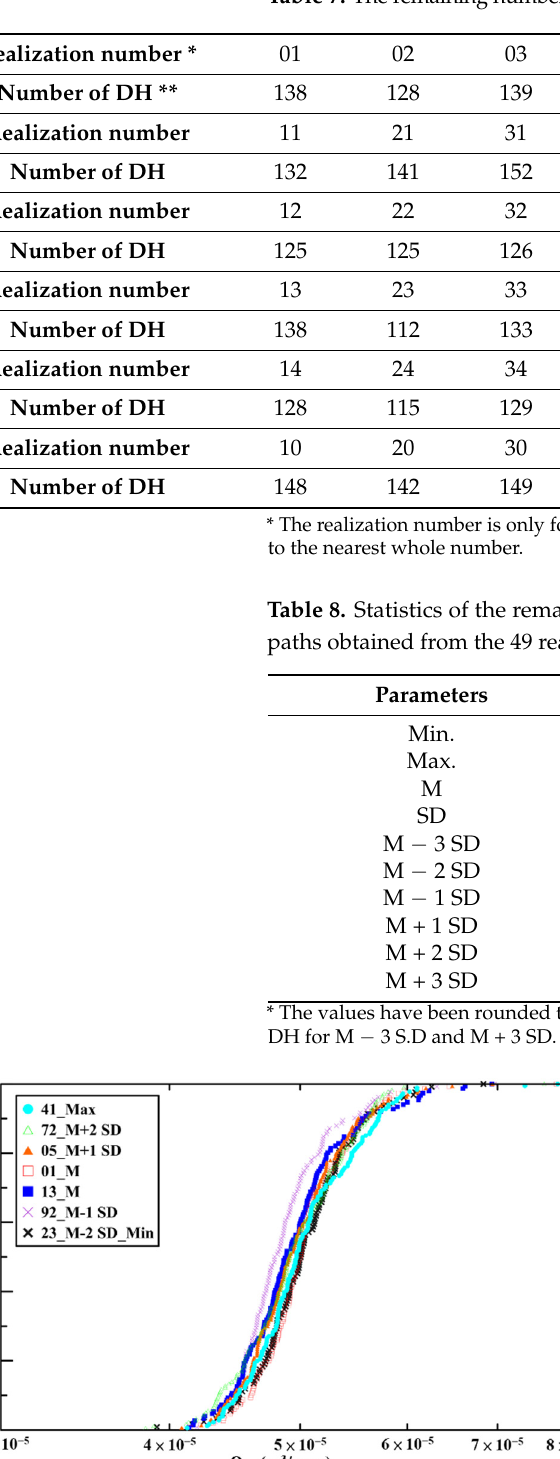
Table 7. The remaining numbers of DHs based on the rejection criteria applied to the 49 DFN realizations.